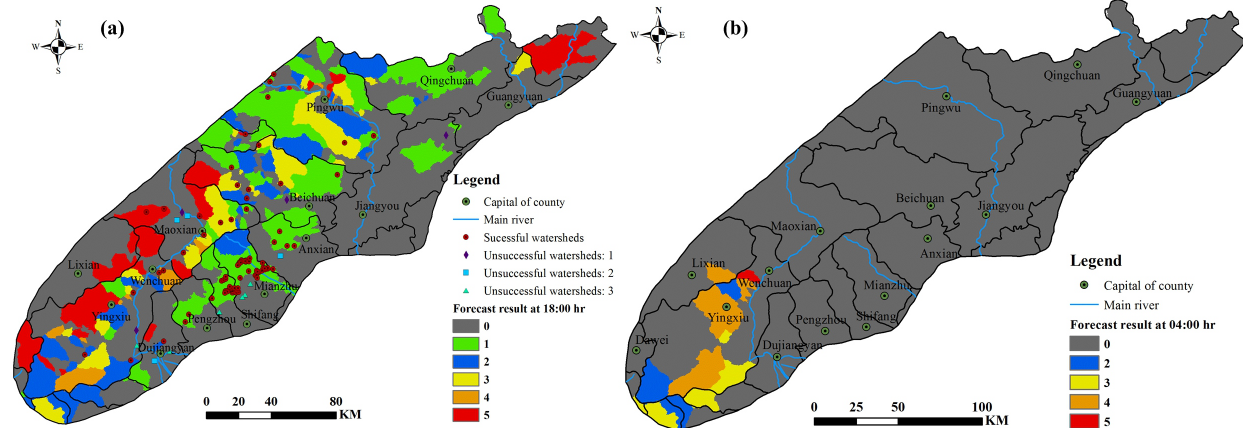
Figure 15. (a) Prediction results of the debris-flow prediction system based on the water–soil coupling mechanism at 18:00p.m. Beijing time zone on 9 July 2013; (b) prediction results of the debris-flow prediction system based on the water–soil coupling mechanism at 04:00a.m. Bei- jing time zone on 10 July 2014.